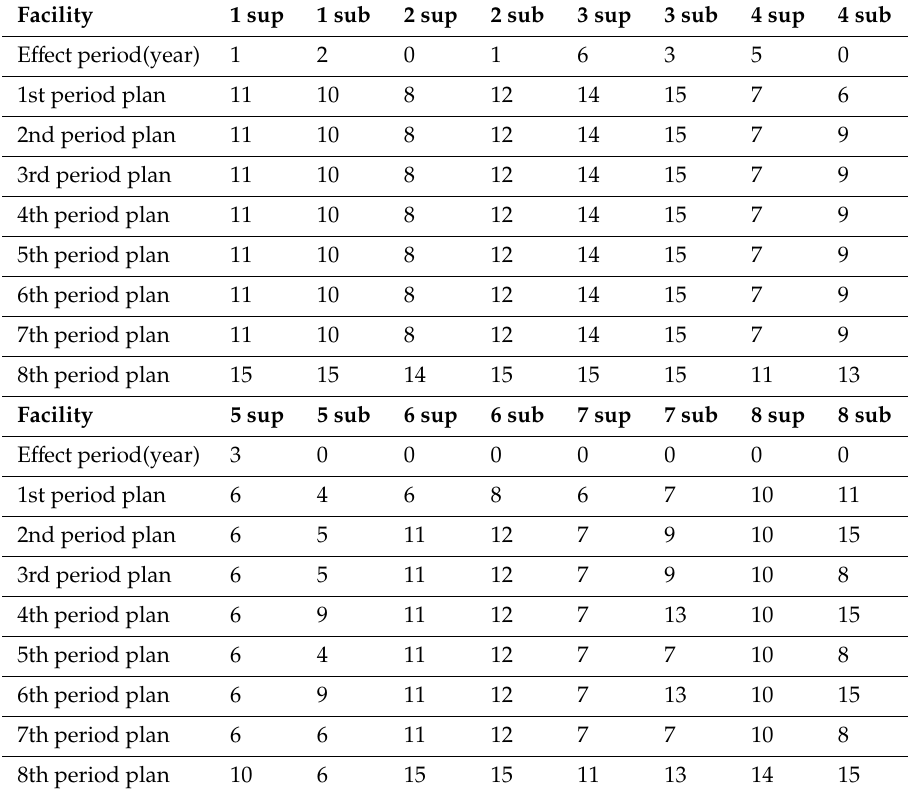
Table 10. Calculation results of e ff ect